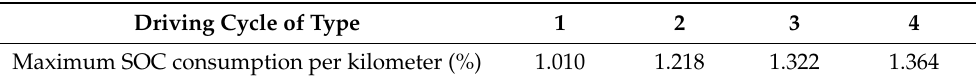
Figure 9. Relationship curve between SOC consumption per kilometer and the average fuel consumption rate under four typical cycles. ( a ) typical cycle 1; ( b ) typical cycle 2; ( c ) typical cycle 3; ( d ) typical cycle 4. According to the relation curve of high efficiency area utilization rate of engine and average fuel consumption rate with SOC consumption per kilometer, reasonable SOC al- location values under four typical cycles can be calculated in SOC trajectory planning. According to the curve relationship shown in Figures 7 and 8, the SOC consumption per kilometer of the vehicle in pure electric mode under four typical cycles can be calculated, as shown in Table 2. At the same time, the distribution upper limit value of SOC under each typical cycles can be obtained, as shown in Table 3.